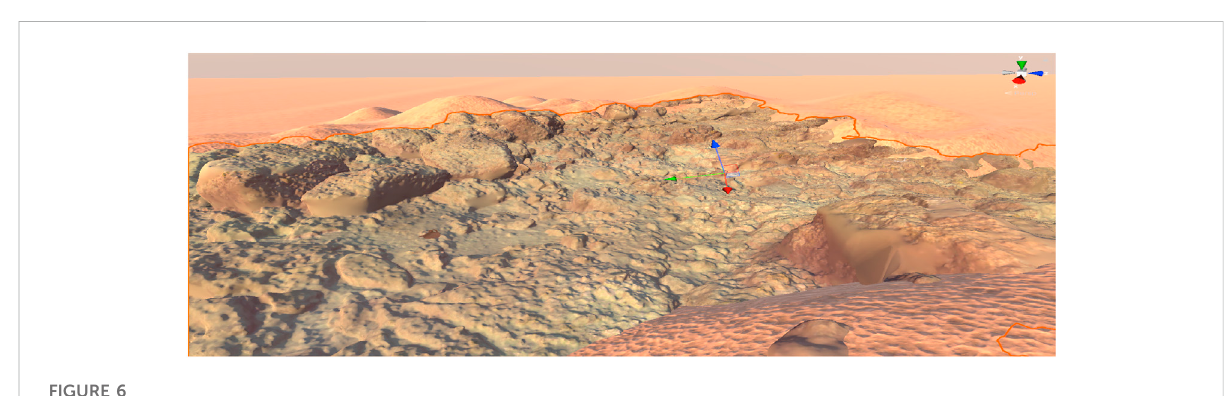
FIGURE 6 SfM model of the wrecksite.